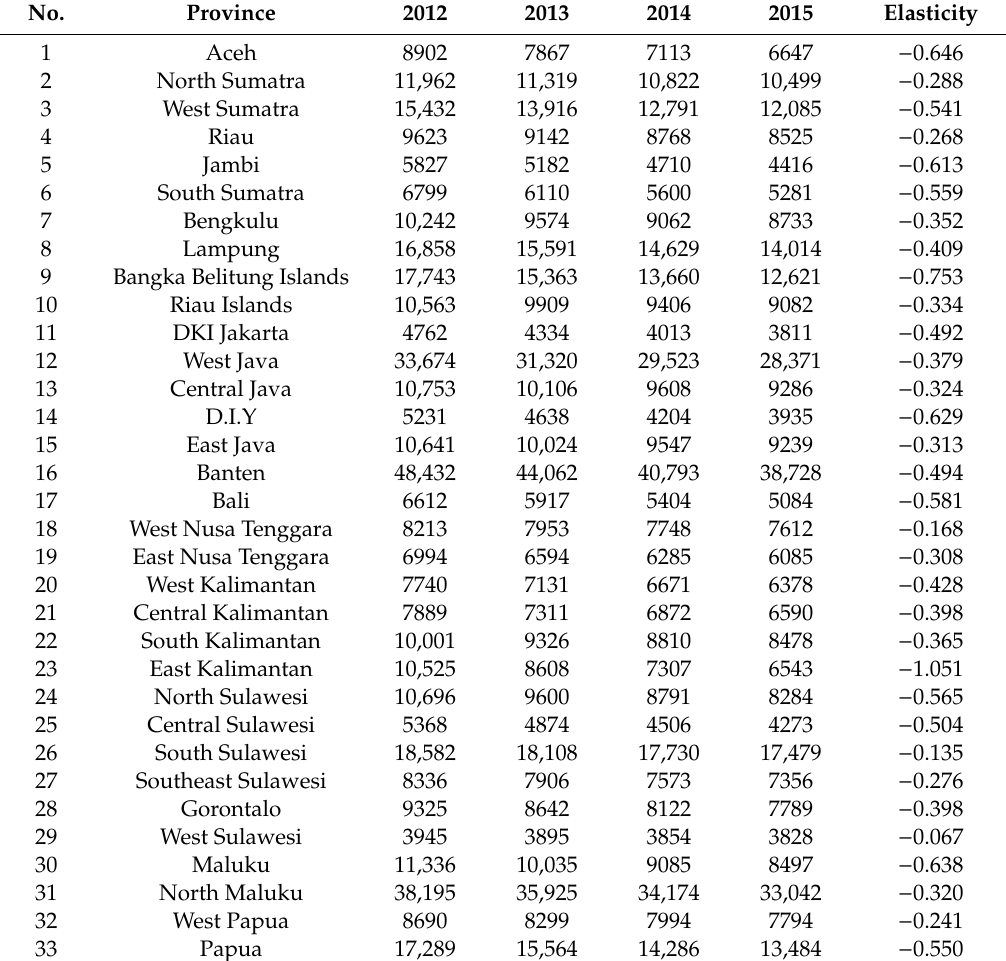
Table 7. Vehicle Kilometers Traveled in Provinces, 2012–2015 (km / car /